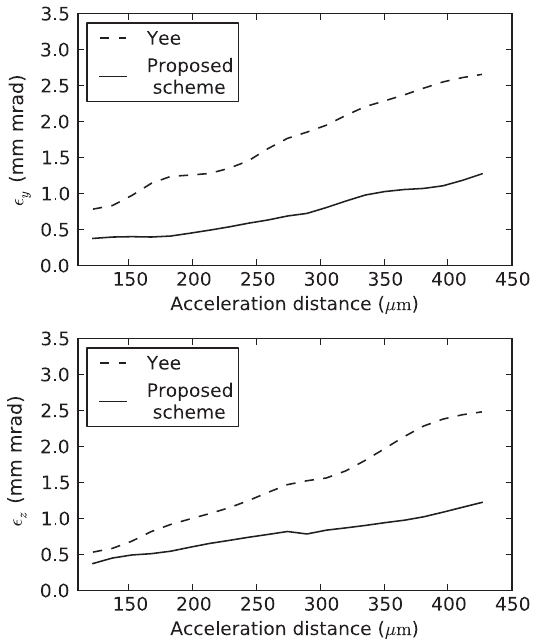
FIG. 9. Transverse emittance of the sub-bunch considered in Fig. 1, in the y (parallel to the laser polarization) and z (orthogonal to the laser polarization) direction, as a function of the acceleration